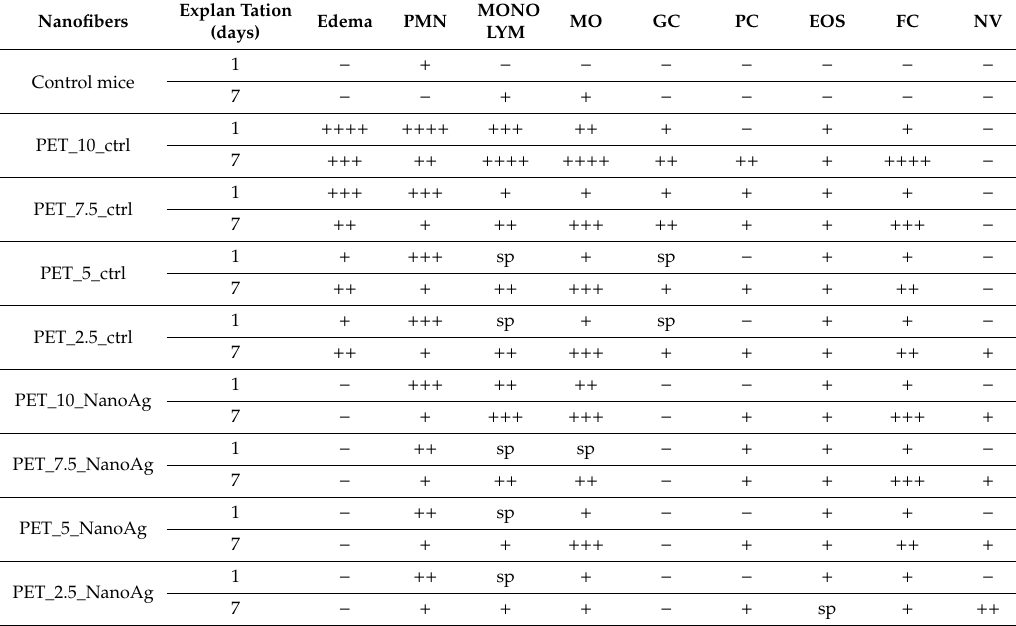
Figure 12. The e ff ects of PET_X_NanoAg subcutaneous implantation in mice on the C-reactive protein Figure 12. The effects of PET_X_NanoAg subcutaneous implantation in mice on the C-reactive (CRP) levels at 24 h and seven days post-surgery. protein (CRP) levels at 24 h and seven days post-surgery. Table 2. Tissue reactions by histometric scoring used to grade inflammation, fibrosis, necrosis, and neovascularization in the tissue surrounding subcutaneous